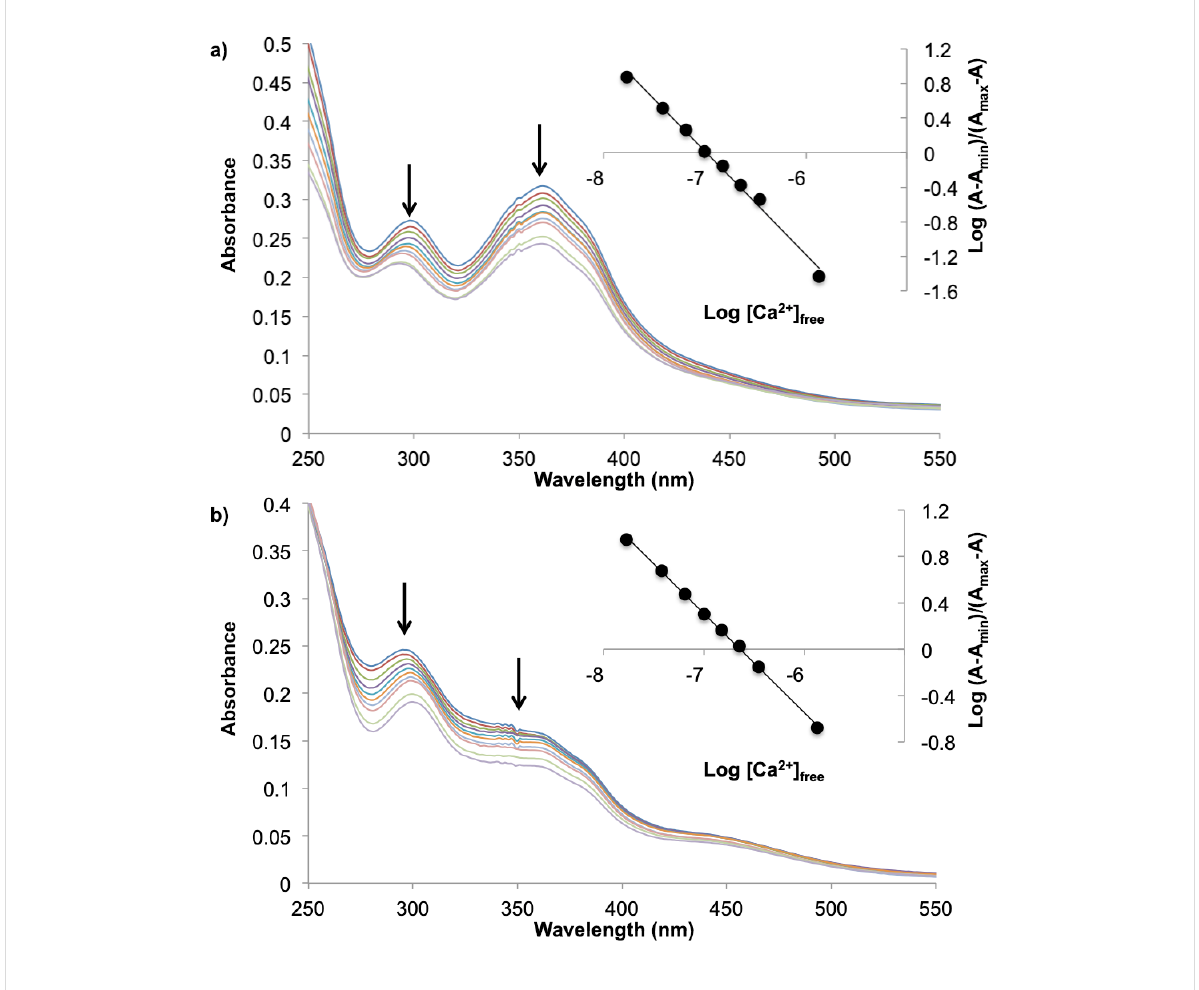
Figure 6: Electronic absorption spectra changes of 1 E (42 μ M) (a) and 1 Z (43 μ M) (b) in aqueous 0.03 M MOPS buffer at pH 7.2 in presence of KCl (0.1 M), and EGTA (0.010 M) upon Ca 2+ addition (free Ca 2+ concentration = 0.017, 0.038, 0.065, 0.100, 0.150, 0.225, 0.35, 1.35 and 39 μ M). Insets: Hill plots for the absorbance change at 305 nm as a function of free Ca 2+ , affording log K d ( x -axis intercept).